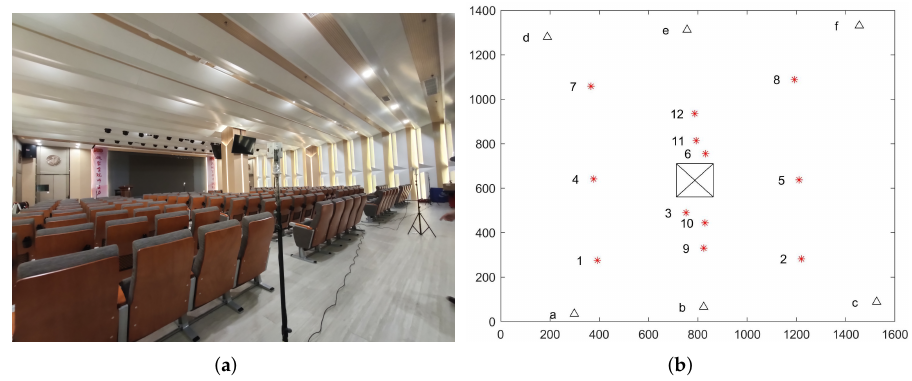
Figure 10. Positioning experiments’ site layout. ( a ) The hall. ( b ) Top view. × representing the load-bearing column in the hall. At the front and back of the hall, a total of six anchor nodes were arranged for ranging, which are represented by ∆ . A tag is placed at Positions 1~12, respectively, as unknown nodes, and the experimental positions are represented by